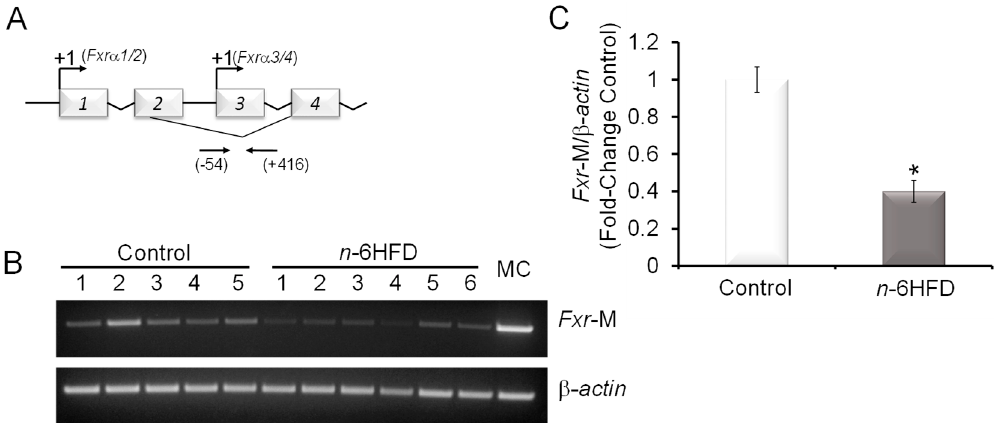
Figure 2. An n -6HFD induces Fxr CpG demethylation in mouse colonic mucosa. ( A ) Organization of the mouse Fxr gene. The top arrows indicate transcription start sites (+1) on exon-1 and exon-3. The bottom arrows indicate positions of oligonucleotides (-54/+416) around exon-3 used for CpG methylation studies [25]. ( B ) PCR bands amplified from bisulfonated genomic DNA obtained from proximal colonic mucosa with mouse Fxr - and β -actin -methylation (M)-specific primers. MC = methylation control. ( C ) Quantitation (fold-change/control) of Fxr promoter methylation status with control ( n = 5) and n -6HFD ( n = 6). Means ± SEM with an asterisk differ ( p < 0.05).